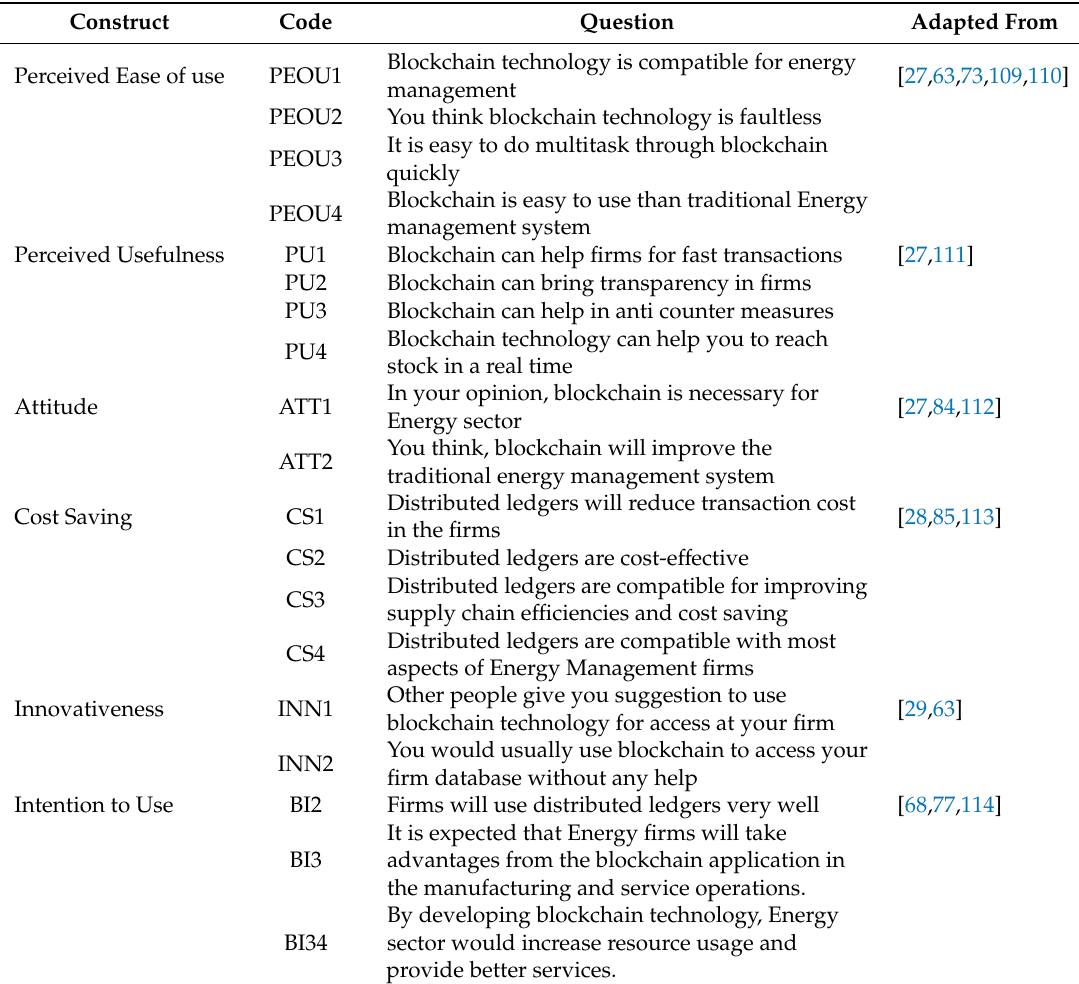
Table 3. Construct